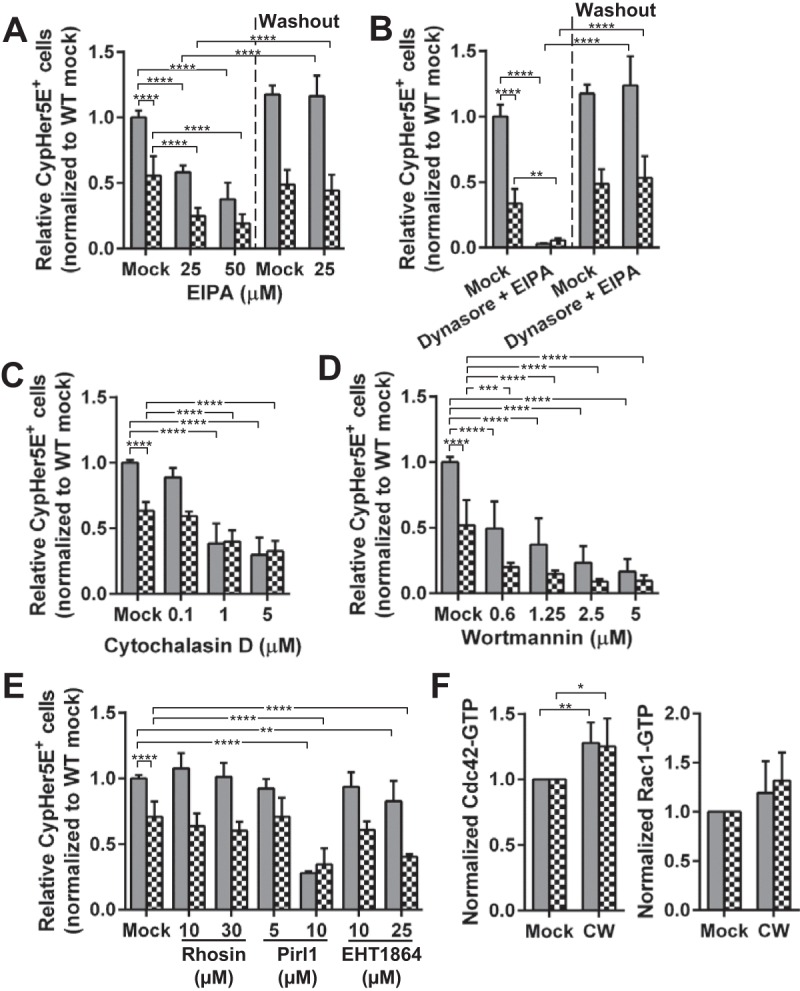
Characteristics of CW uptake independent of PAFr. (A to E) WT MLEC (gray bars) and PAFr KO MLEC (checkerboard bars) were pretreated with EIPA (A), 80 µM dynasore and 25 µM EIPA (B), cytochalasin D (C), wortmannin (D), rhosin (E), Pirl1 (E), and EHT1864 (E) at the indicated concentrations. The cells were incubated with CypHer5E-labeled CW and processed and analyzed as described in the legend to Fig. 1C. Data are presented as means plus SD from three independent experiments. **, P < 0.01; ***, P < 0.001; ****, P < 0.0001 (Bonferroni’s multiple-comparison test). (F) WT MLEC and PAFr KO MLEC were incubated with 106 bacterial equivalents of CW for 1 h at 37°C, incubated immediately on ice, washed once with ice-cold PBS, and lysed and processed as described in Materials and Methods. Quantification of the GTP-bound Cdc42 or Rac1 in the lysates was performed. Data are presented as means plus SD from five (Cdc42) or three (Rac1) independent experiments. *, P < 0.05; **, P < 0.01 (Bonferroni’s multiple-comparison test).